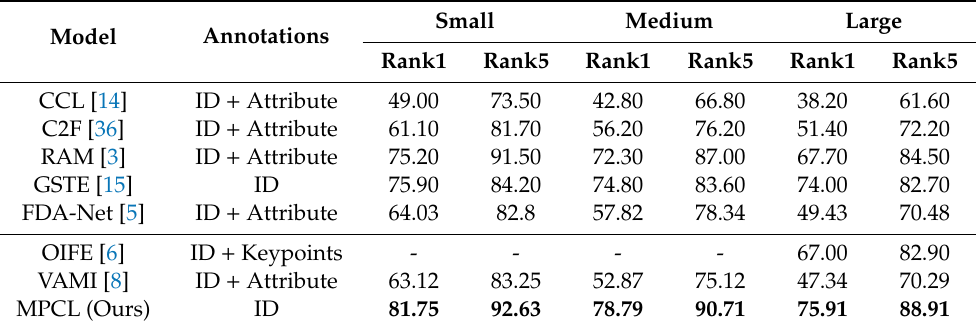
Table 2. Results of Top-k metric (%) on VehicleID